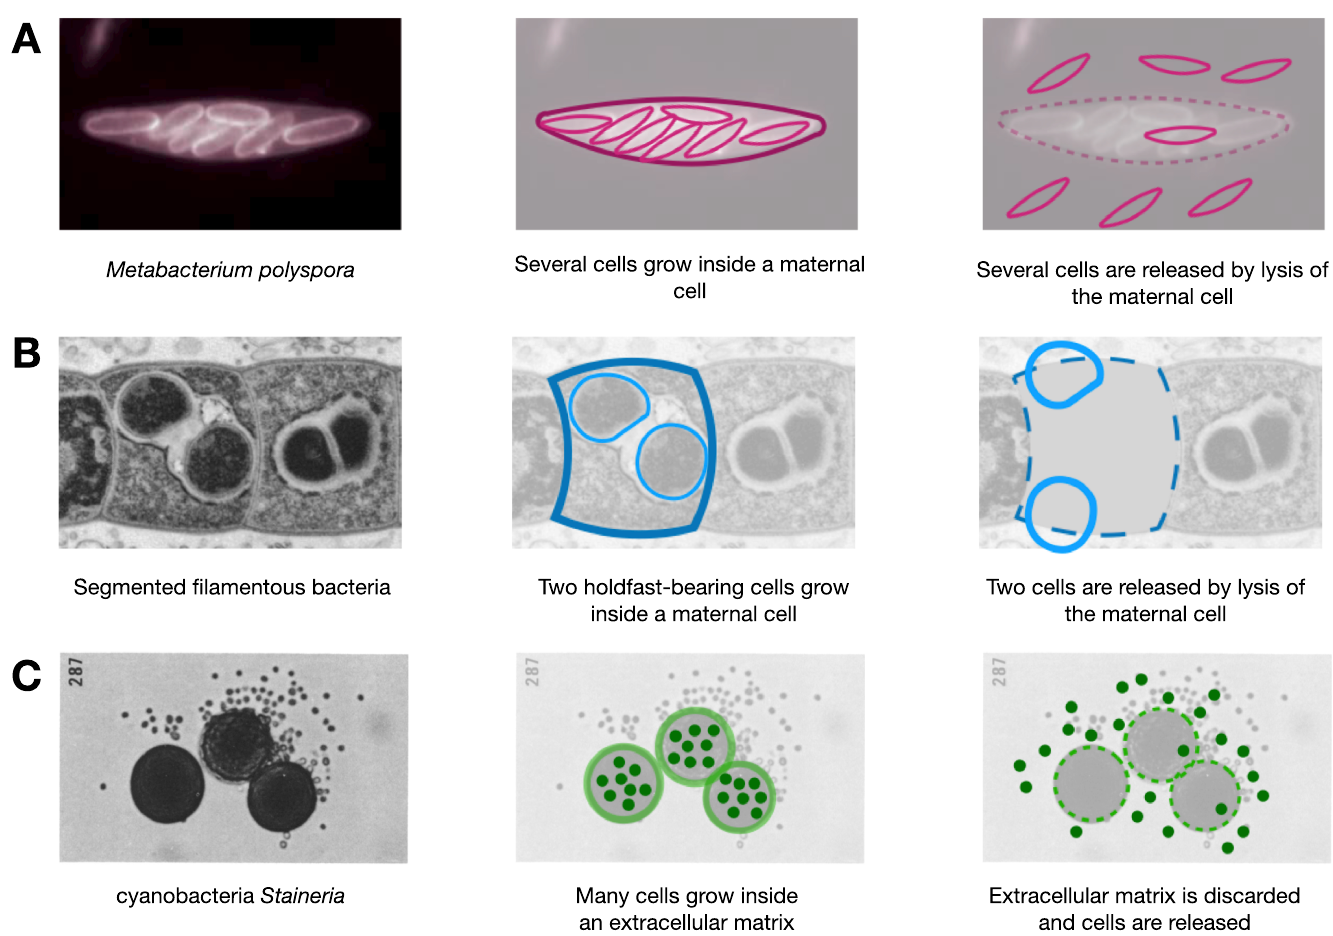
Fig 1. Examples of multiple fragmentation in nature and their interpretation in terms of our model. ( A ) M. polyspora grows multiple endopsora, released after the maternal cell lysis (picture adopted from [27], Copyright (1998) National Academy of Sciences). ( B ) segmented filamentous bacteria grows two holdfast-bearing cells inside a maternal cell. These cells are released in the result of the maternal cell lysis (picture adopted from [29]). The death of maternal cells is the fragmentation cost in these two examples. ( C ) genus Stanieria grows multiple cells within a single extracellular matrix. These cells are released simultaneously upon the break of the matrix (Picture adopted from [30]). The loss of the extracellular matrix corresponds to a fragmentation cost here.